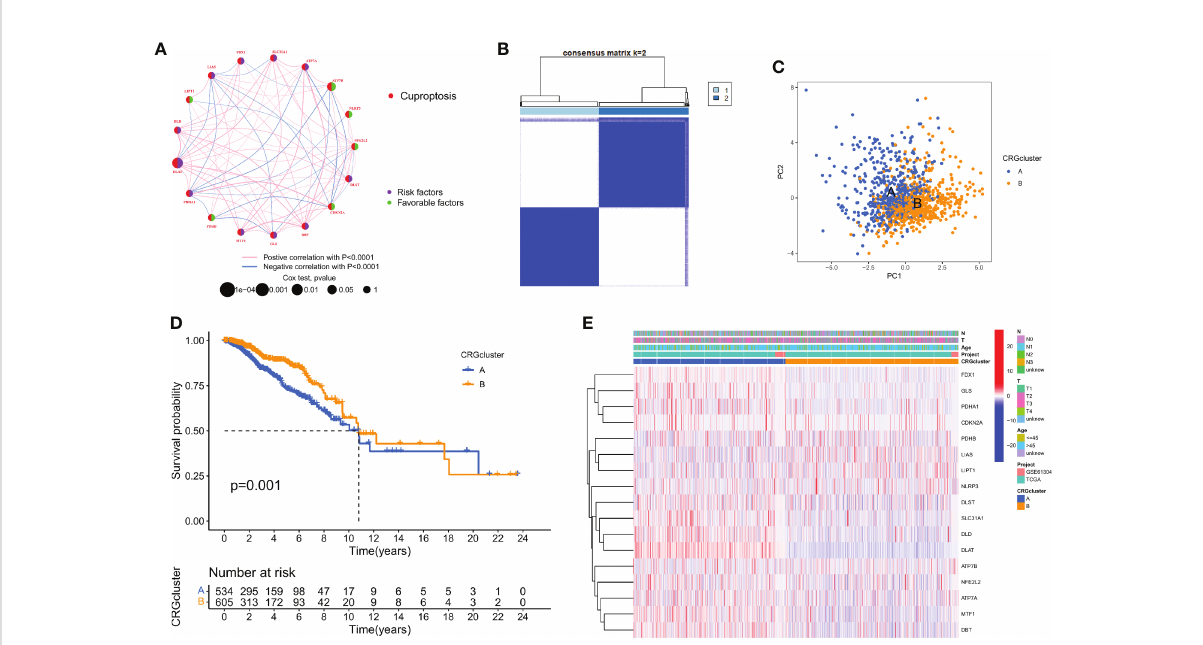
FIGURE 2 Biological and clinicopathological characteristics of CRG subtypes. (A) The interactions between CRGs in BC (the red and blue strings denote positive and negative correlation, respectively; the intensity of the correlation is indicated by the color shades). (B) The consensus matrix's heatmap of two clusters ( k = 2). (C) A considerable transcriptome divergence between the two subtypes is seen by PCA analysis. (D) Subtype- speci fi c Kaplan-Meier OS curves. (E) CRG expression levels and clinicopathological traits vary across